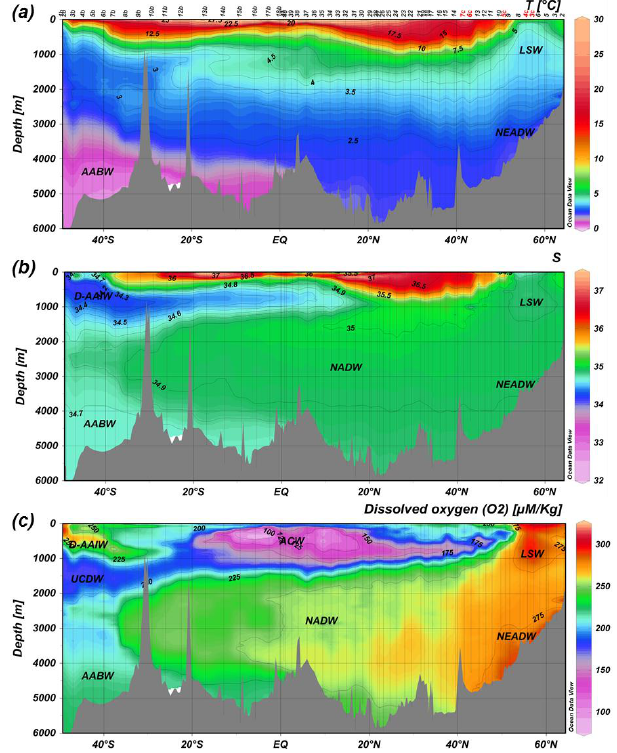
Fig. 2. Interpolated vertical sections of (a) temperature ( T ), (b) salinity ( S ) and (c) dissolved oxygen (O 2 ) along the GEOTRACES-A02 section in the western Atlantic, based on CTD data. The different water masses – LSW, NEADW, NADW, ACW, AABW, D-AAIW and UCDW – are identified by their physical fea- tures and are indicated in the figure panels. Stations sampled during leg 4 are labeled in